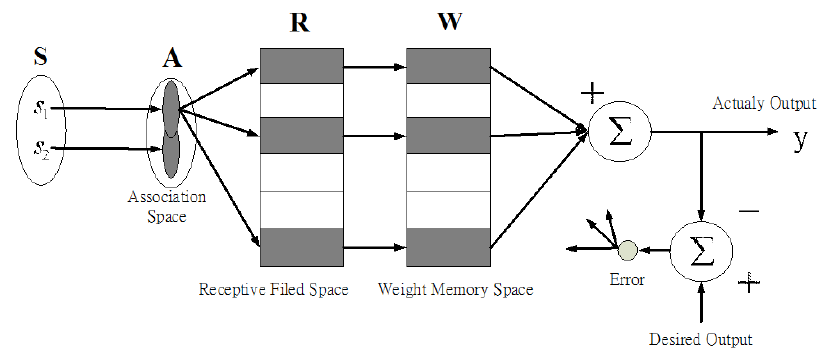
Figure 2. The basic structure of CMAC.